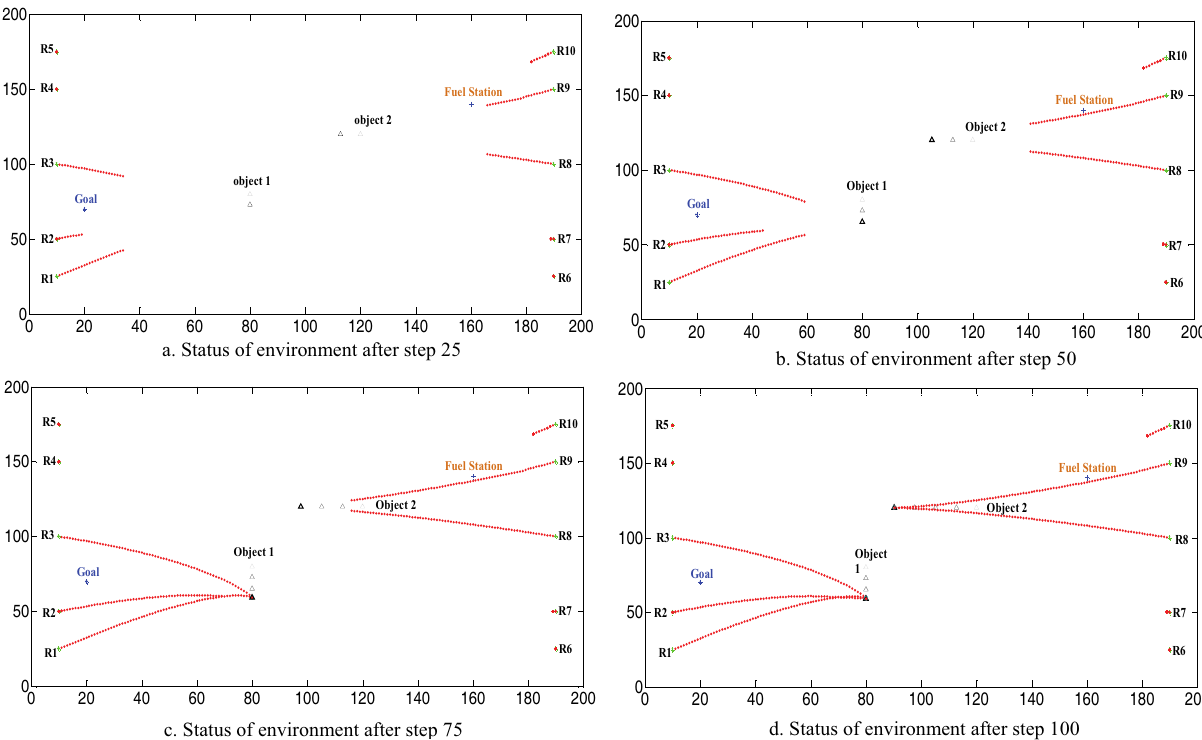
Fig. 11. Four snapshots of two-object foraging with straight motion of the